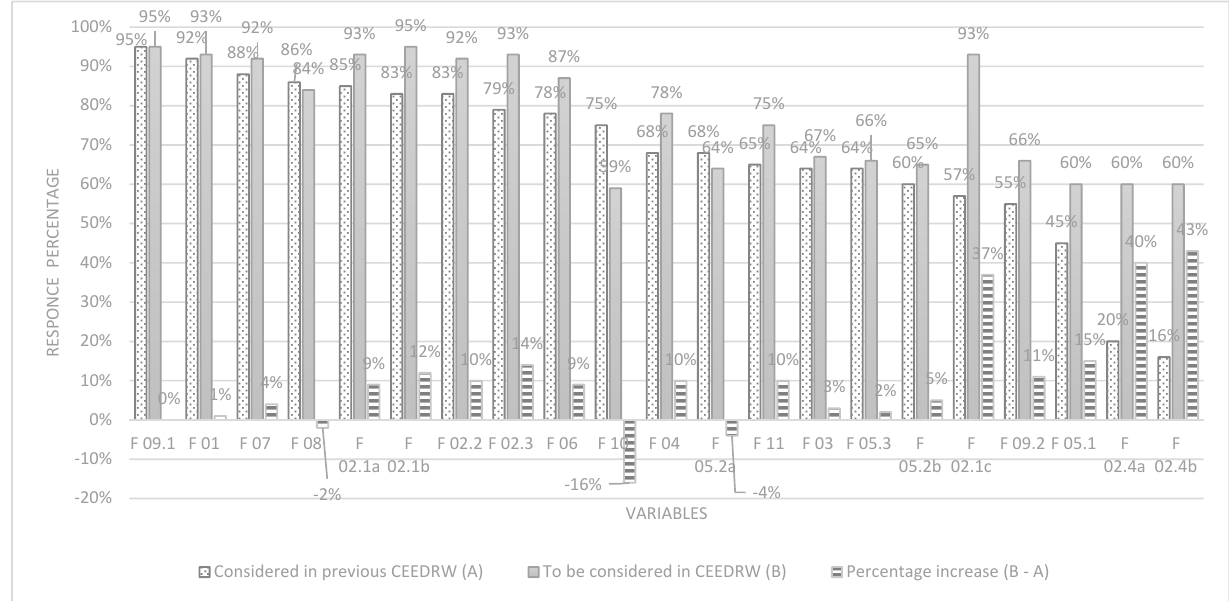
Figure 2. Comparison between variables that were considered in previous CEEDRW and variables that should be included in CEEDRW.